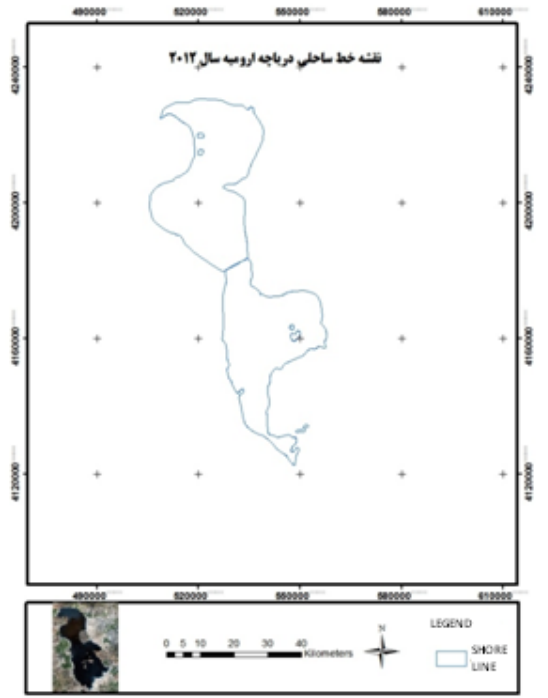
Figure 17: Urmia lake shoreline in 2012